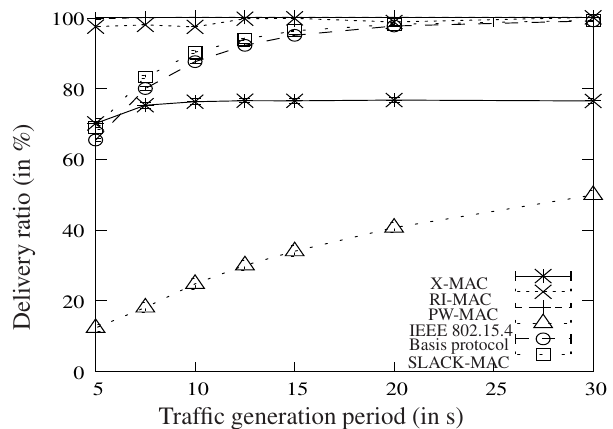
Figure 6. Delivery ratio as a function of the traffic generation period, for a duty-cycle of 1 %, and for several protocols.